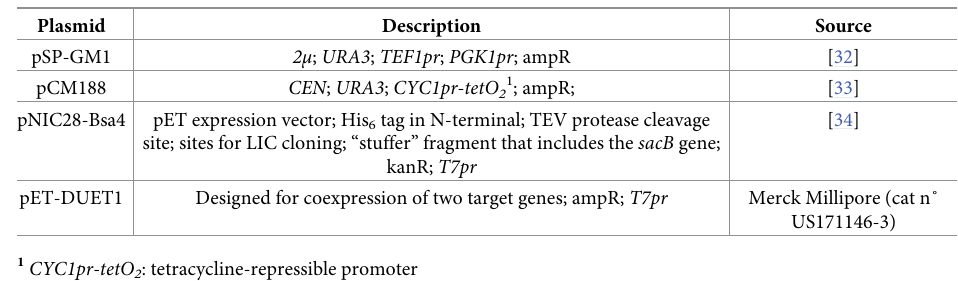
Table 1. Plasmids used in this study.